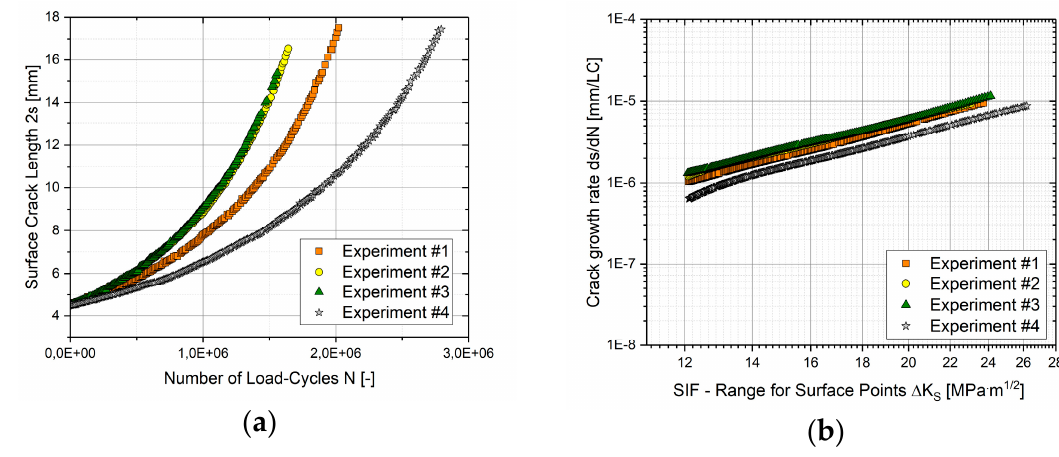
Figure 9. Results of rotating bending experiments: ( a ) Surface crack length in dependence of load-cycles and ( b ) Crack growth rate vs. Δ K S .